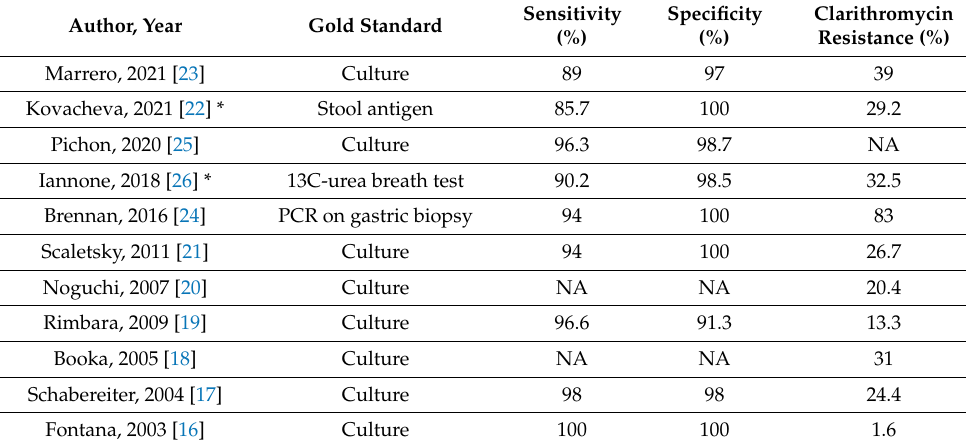
Table 1. Studies on H. pylori stool DNA by real time polymerase chain reaction (RT-PCR) for diagnosis of infection and/or antibiotic susceptibility